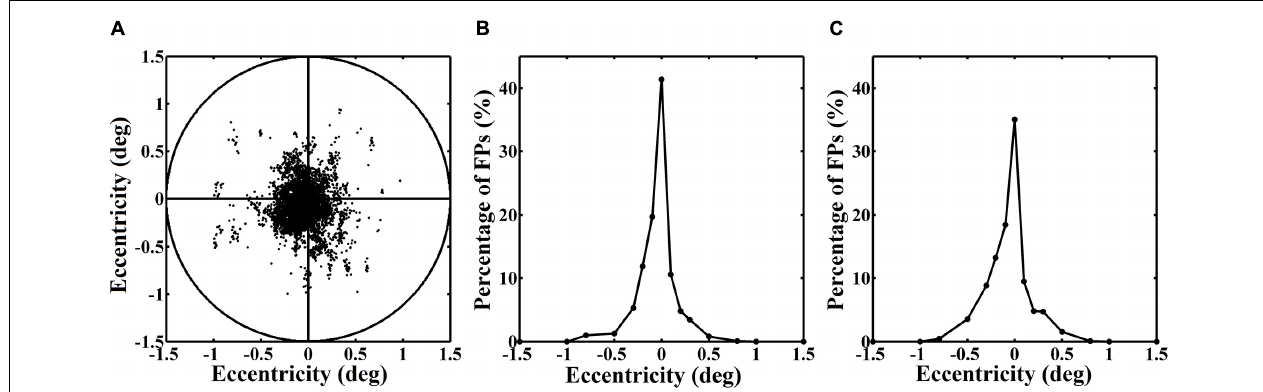
FIGURE 3 | (A) Distribution of the real fixation positions (FPs) of the eyes in one block. (B) and (C) Distributions of the relative number (%) of the real FPs over the horizontal and vertical